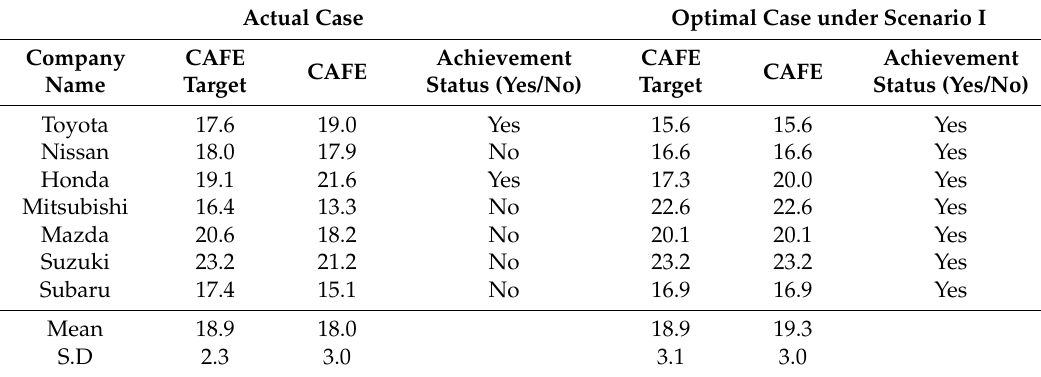
Table 3. CAFEs and CAFE targets of seven automobile manufacturers for the actual and optimal cases. Actual